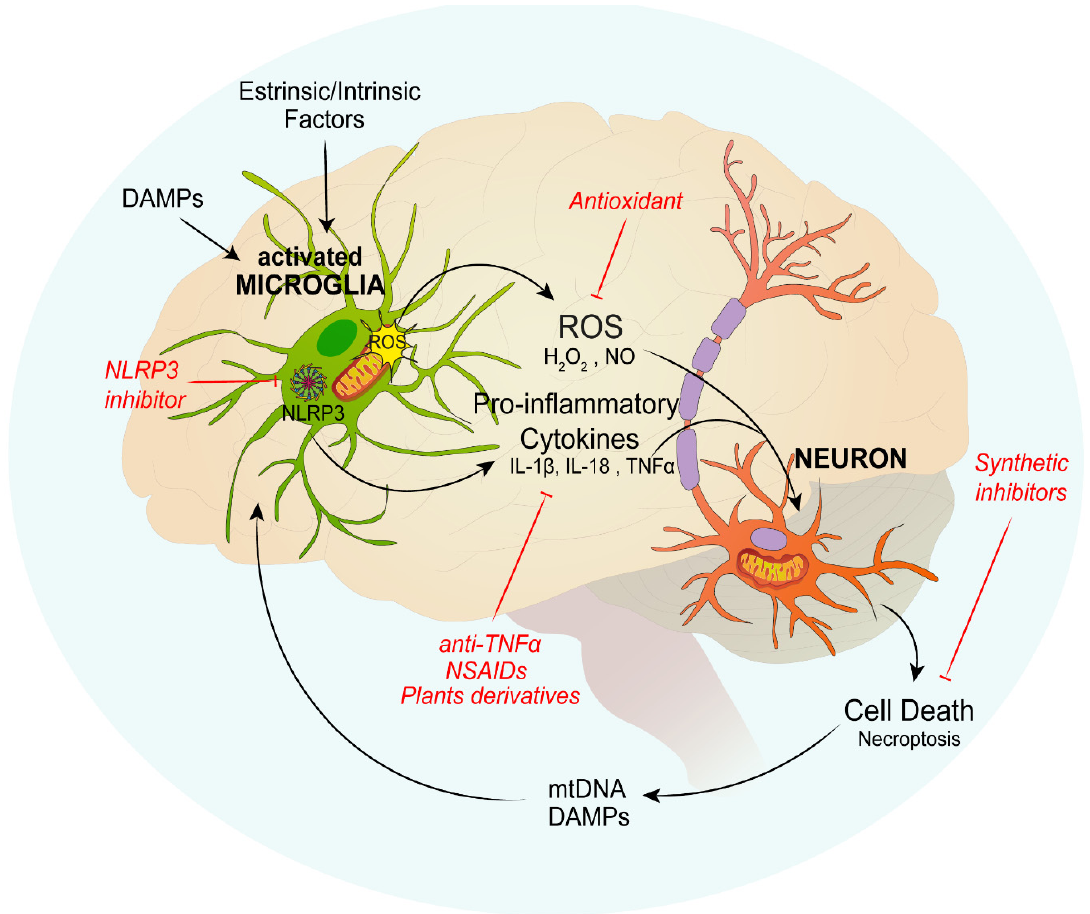
Figure 2. Involvement of mitochondrial dysfunction and neuroinflammation in the development of neurodegenerative diseases. DAMPs or extrinsic/intrinsic factors activate microglia that lead to ROS production and proinflammatory cytokines release that in turn alter neuronal functions and induce cell death. This creates a vicious cycle that favors mtDNA and DAMP production, activating the NLRP3 inflammasome. Selective NLRP3 inhibitors, antioxidants, specific inhibitors that block the necroptotic pathway, anti-TNF α , NSAIDs and plant derivatives can prevent this mechanism. DAMPs: damage-associated molecular patterns; NLRP3: NOD-, LRR- and pyrin domain-containing 3; NSAID: nonsteroidal anti-inflammatory drugs; mtDNA: mitochondrial DNA; ROS: reactive oxygen species.